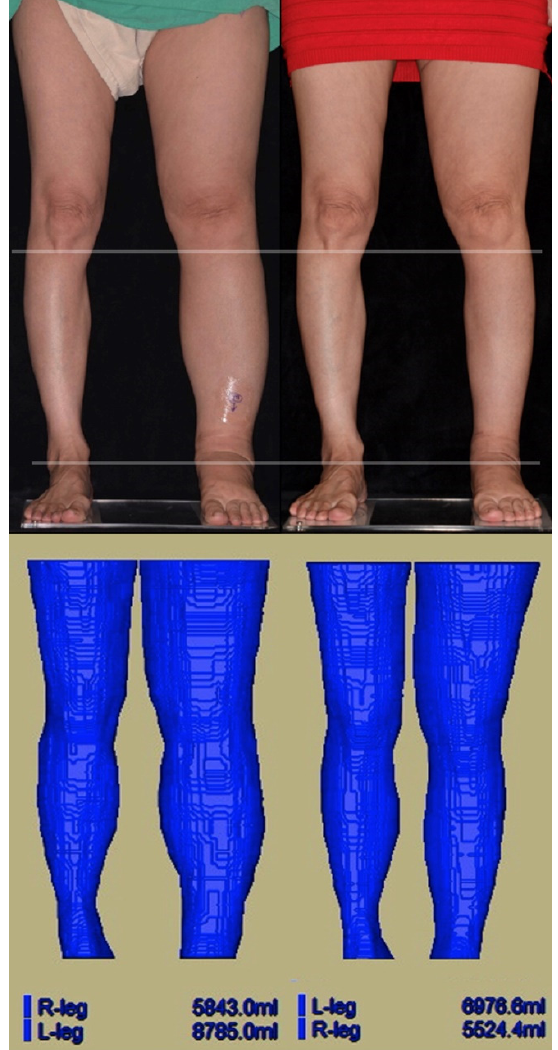
Figure 2. A 55-year-old woman with a BMI of 22.1 kg/m 2 post-cervical cancer ablation and lymph node dissection (23 years prior). She has suffered from stage III lymphedema on her left lower limb for the past seven years with frequent cellulitis. A total of nine lymphaticovenous anastomoses (LVAs) were performed. (Upper left) Pre-LVA. (Upper right) Six months post-LVA follow-up. (Lower left) Preoperative MR volumetry showing a left lower limb volume of 8785.0 mL; right lower limb volume of 5843.0 mL. The volume gained in the left lower limb due to lymphedema was 2942.0 mL (8785.0 mL minus 5843.0 mL). (Lower right) Six months post-LVA MR volumetry showing left limb volume of 6976.6 mL. Post-LVA volume reduction was − 1808.4 mL (a − 61.5% lymphedema volume reduction).